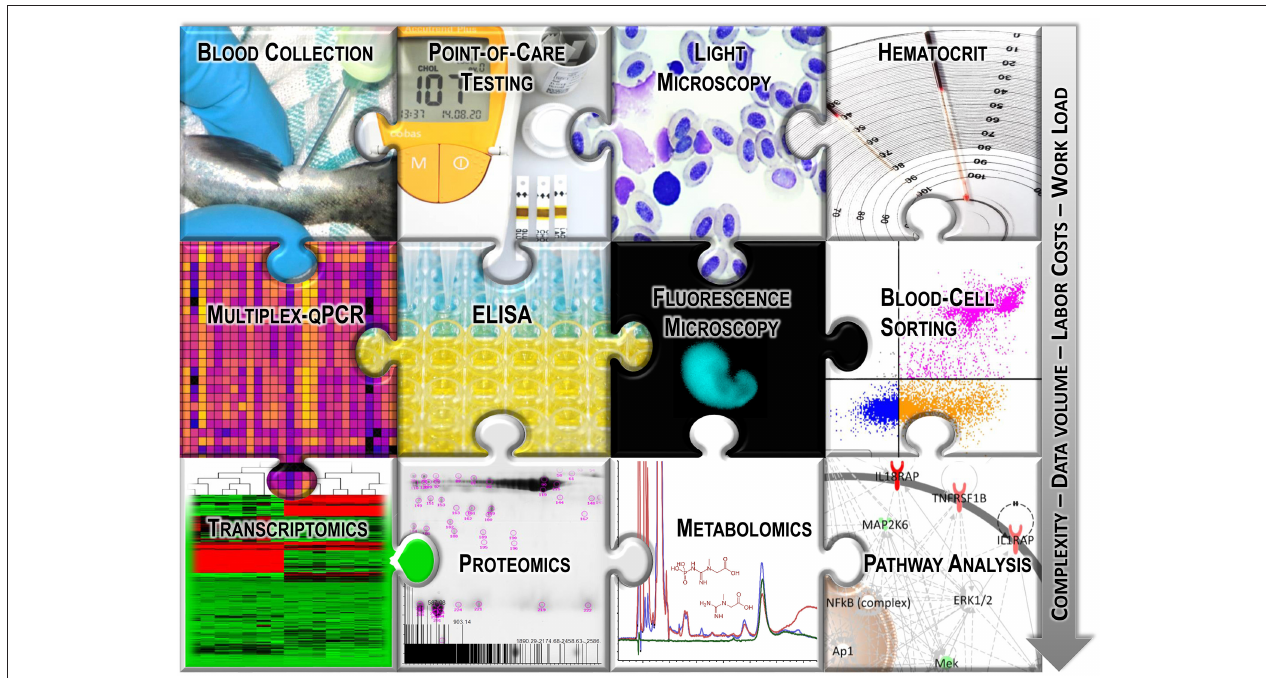
FIGURE 1 | Graphical overview of the selected analysis techniques used with fish